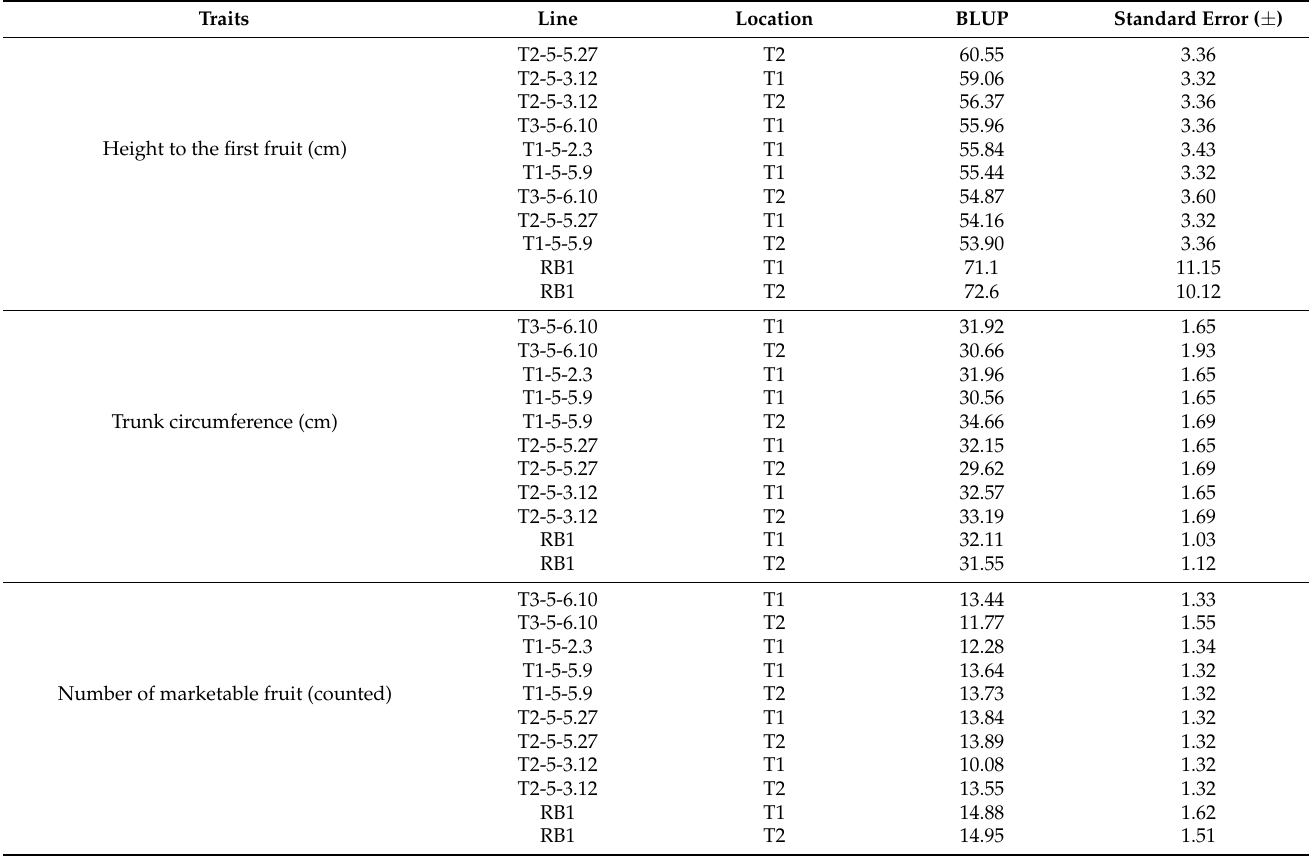
Table 4. F5 RIL ranked for the breeding value or genetic worth (BLUPs) of each trait in the Tablelands environment (T1 and T2) compared to commercial